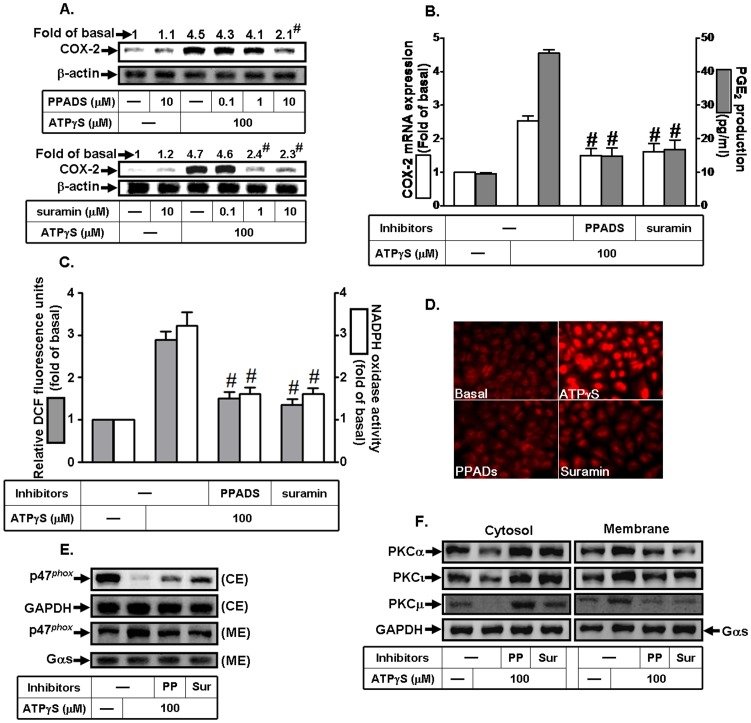
ATPγS induces P2 receptor-dependent COX-2 expression, PKC translocation, and ROS generation in A549 cells.Cells were pretreated with PPADS or suramin for 1 h, and then treated with ATPγS for (A) 6 h or (B) 2 h. The levels of COX-2 (A) protein and (B) mRNA were analyzed by western blot and real-time PCR, respectively. (A) The media were collected and analyzed for PGE2 release. (C) Cells were labeled with DCF-DA (10 µM), pretreated with PPADS or suramin for 1 h, and then incubated with ATPγS for 1 h. The fluorescence intensity (relative DCF fluorescence) was measured (gray bar). In addition, NADPH oxidase activity was determined (white bar). (D) Cells were pretreated with PPADS or suramin for 1 h, and then incubated with ATPγS for 1 h. After incubation, ROS generation was determined by using CellROX™ Deep Red Reagent as described in Fig. 2E. (E) Cells were pretreated with PPADS (10 µM) or suramin (10 µM) for 1 h, and then incubated with ATPγS for 1 h. The membrane and cytosolic fractions were prepared and analyzed by western blot using an anti-p47phox antibody. (F) Cells were pretreated with PPADS (10 µM) or suramin (10 µM) for 1 h, and then treated with ATPγS for 15 min. The cytosolic and membrane fractions were prepared and analyzed by western blot using an anti-PKCα, anti-PKCι, or anti-PKCμ antibody. Data are expressed as mean±S.E.M. of three independent experiments. #
p<0.01, as compared with the cells exposed to ATPγS alone.